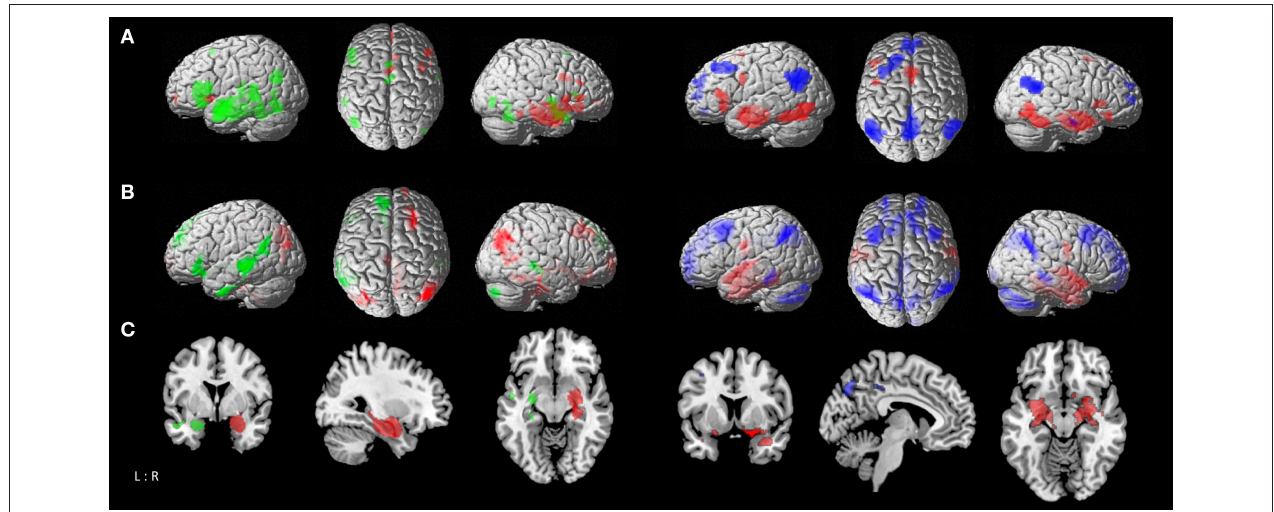
FIGURE 2 | Comparison of functional connectivity maps between atrophy seeds. (A) left : MACM contrasts between left and right temporal seeds, with green areas showing stronger connectivity to left temporal seed, and red areas showing stronger connectivity to right temporal seed; right : MACM contrasts of parietal seed against the conjunction of left and right temporal seeds, with blue areas showing stronger connectivity to parietal seed, and red areas showing stronger connectivity to both right and left temporal seeds. (B) left : Resting-state connectivity contrasts between left and right temporal seeds; right : contrast of parietal seed against the conjunction of left and right temporal seeds [color coding as in A]. (C) Conjunction of MACM and resting-state contrast maps; left : contrasts between left and right temporal seeds; right : contrast of parietal seed against the conjunction of left and right temporal seeds [color coding as in (A)